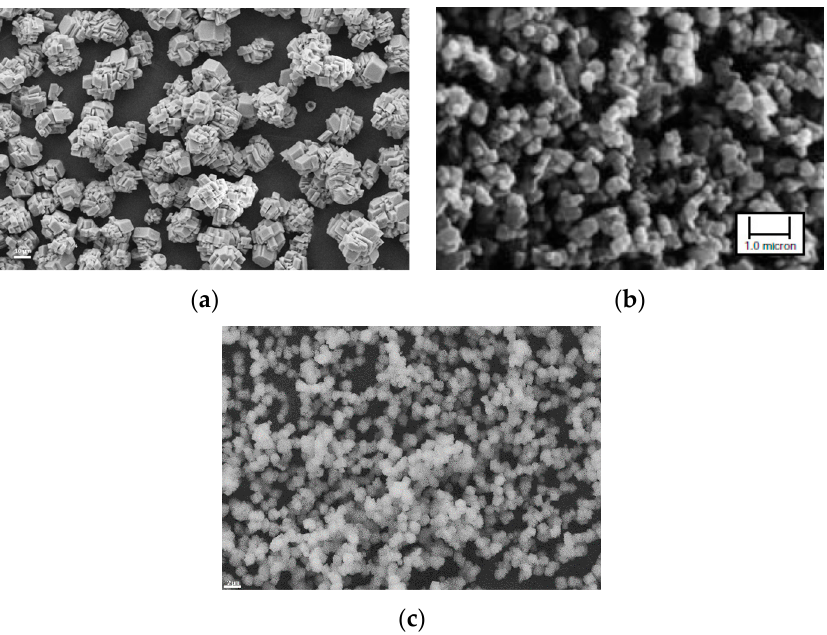
Figure 9. PCC products produced from steel converter (BOF) slag using the slag2PCC concept with a 1 M ammonium chloride solvent: ( a ) rhombohedral calcite particles; ( b ) cubic calcite particles; and ( c ) spherical vaterite particles. Scale bar in ( b ): 1 µm.